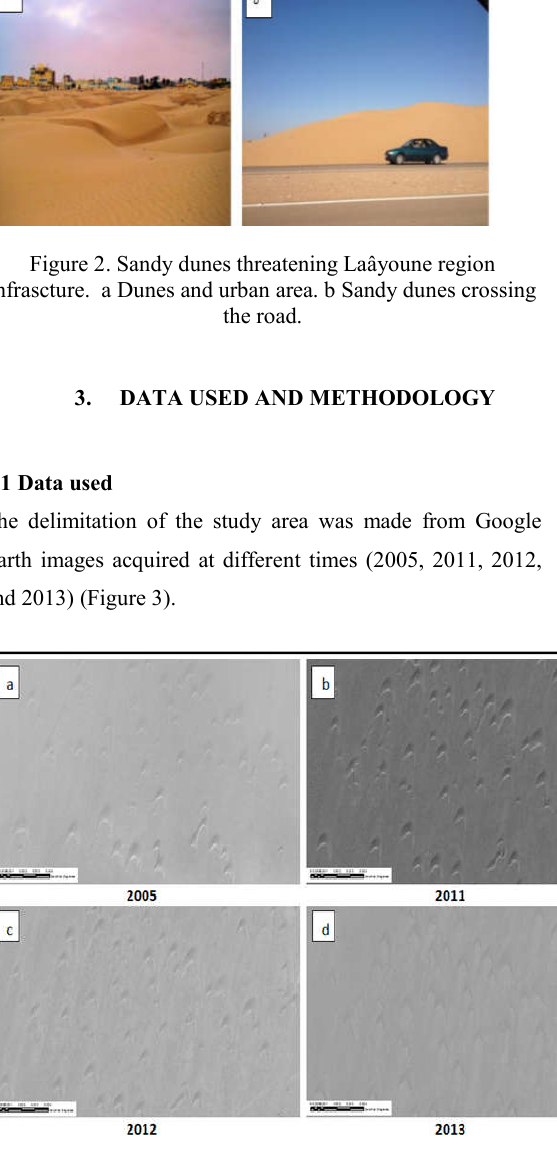
Figure 3. Google Earth images